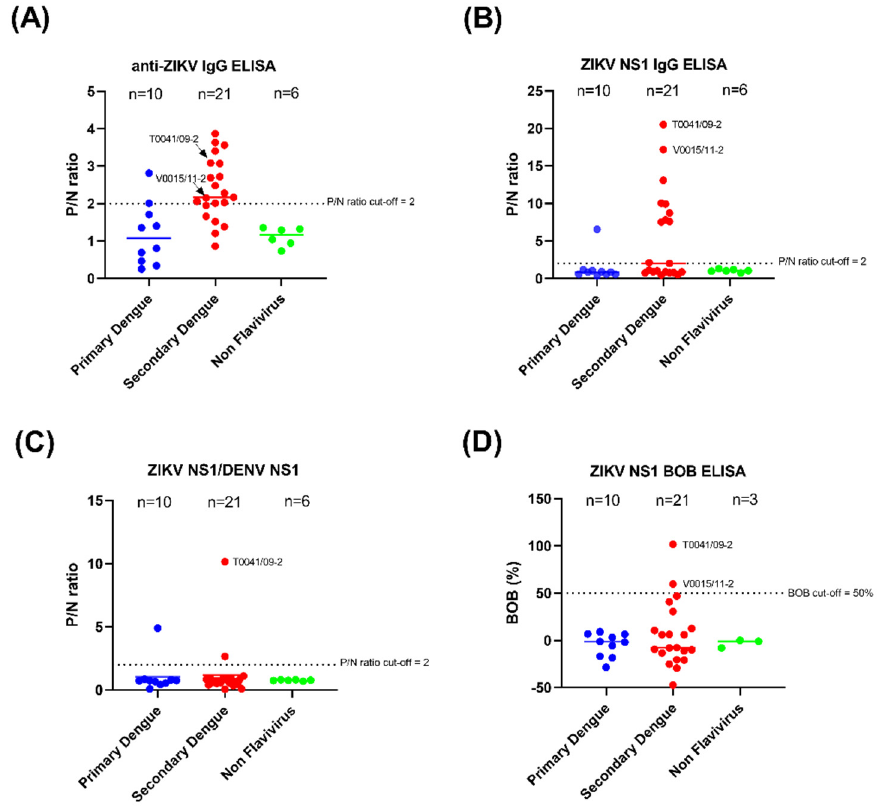
Figure 1. The performance of serological assays using DENV infection samples in the convalescent phase. ( A ) anti-ZIKV IgG ELISA. ( B ) ZIKV NS1 IgG ELISA. ( C ) ZIKV NS1/DENV NS1 IgG ELISA.